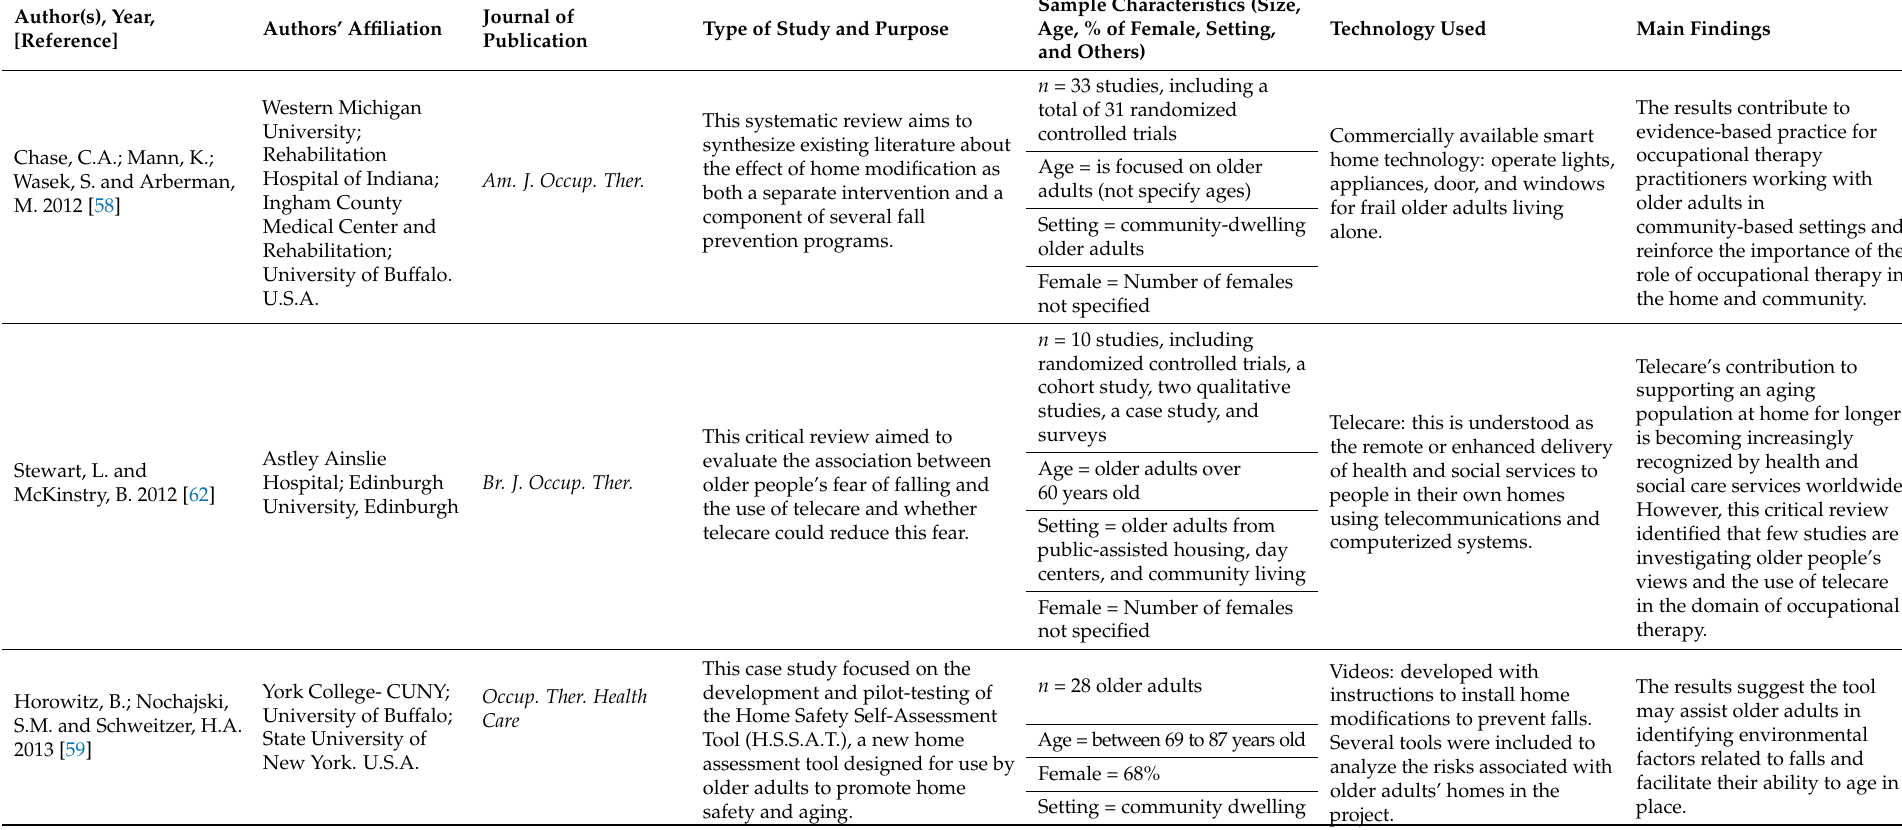
Table 2. Summary of data extracted from the 12 selected